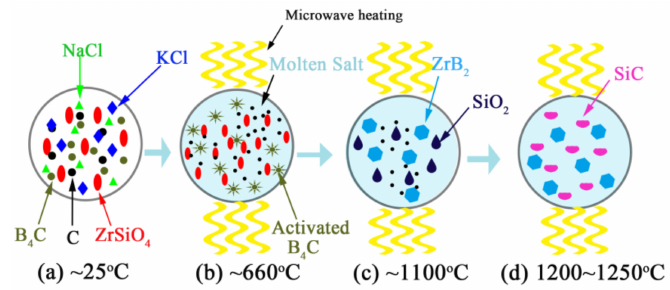
Figure 11. A schematic diagram of the MSM-BCTR process of ZrB 2 -SiC